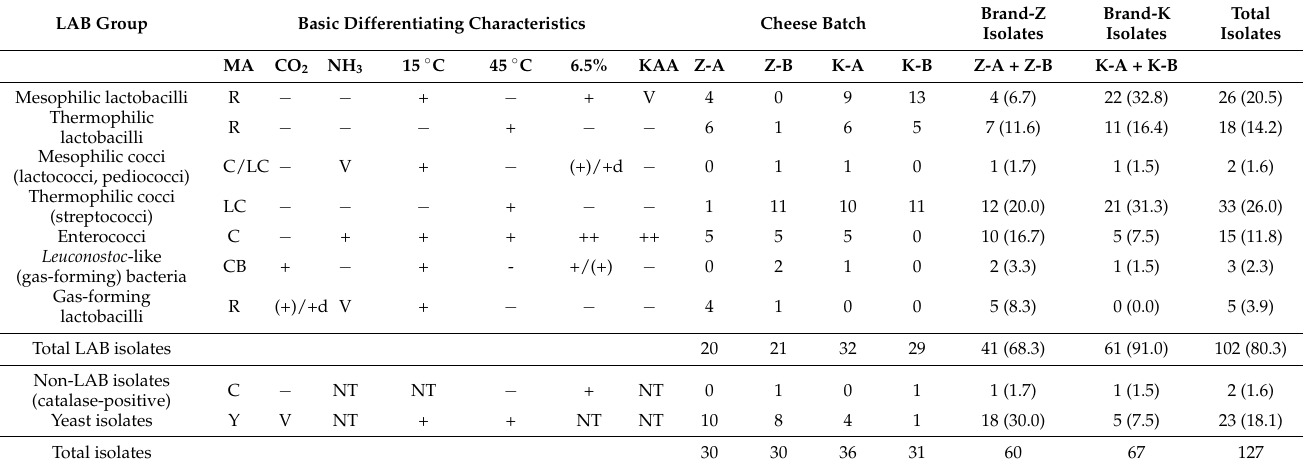
Table 3. Biochemical characterization and main grouping of 102 LAB isolates (plus additional 25 non-LAB or yeast isolates) from Galotyri PDO cheese in accordance to their numerical distribution in each of the four batches analyzed, and their cheese brand or total percent isolation frequency 1